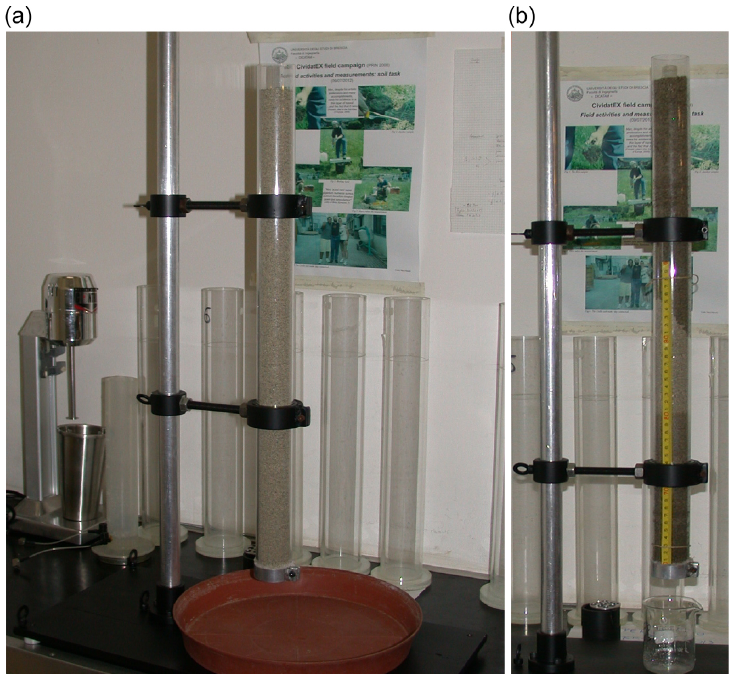
Figure 5. Laboratory setup of the soil column (a) and the soil column during the second part of the first experiment, when the top and the bottom imbibition fronts meet (b) .